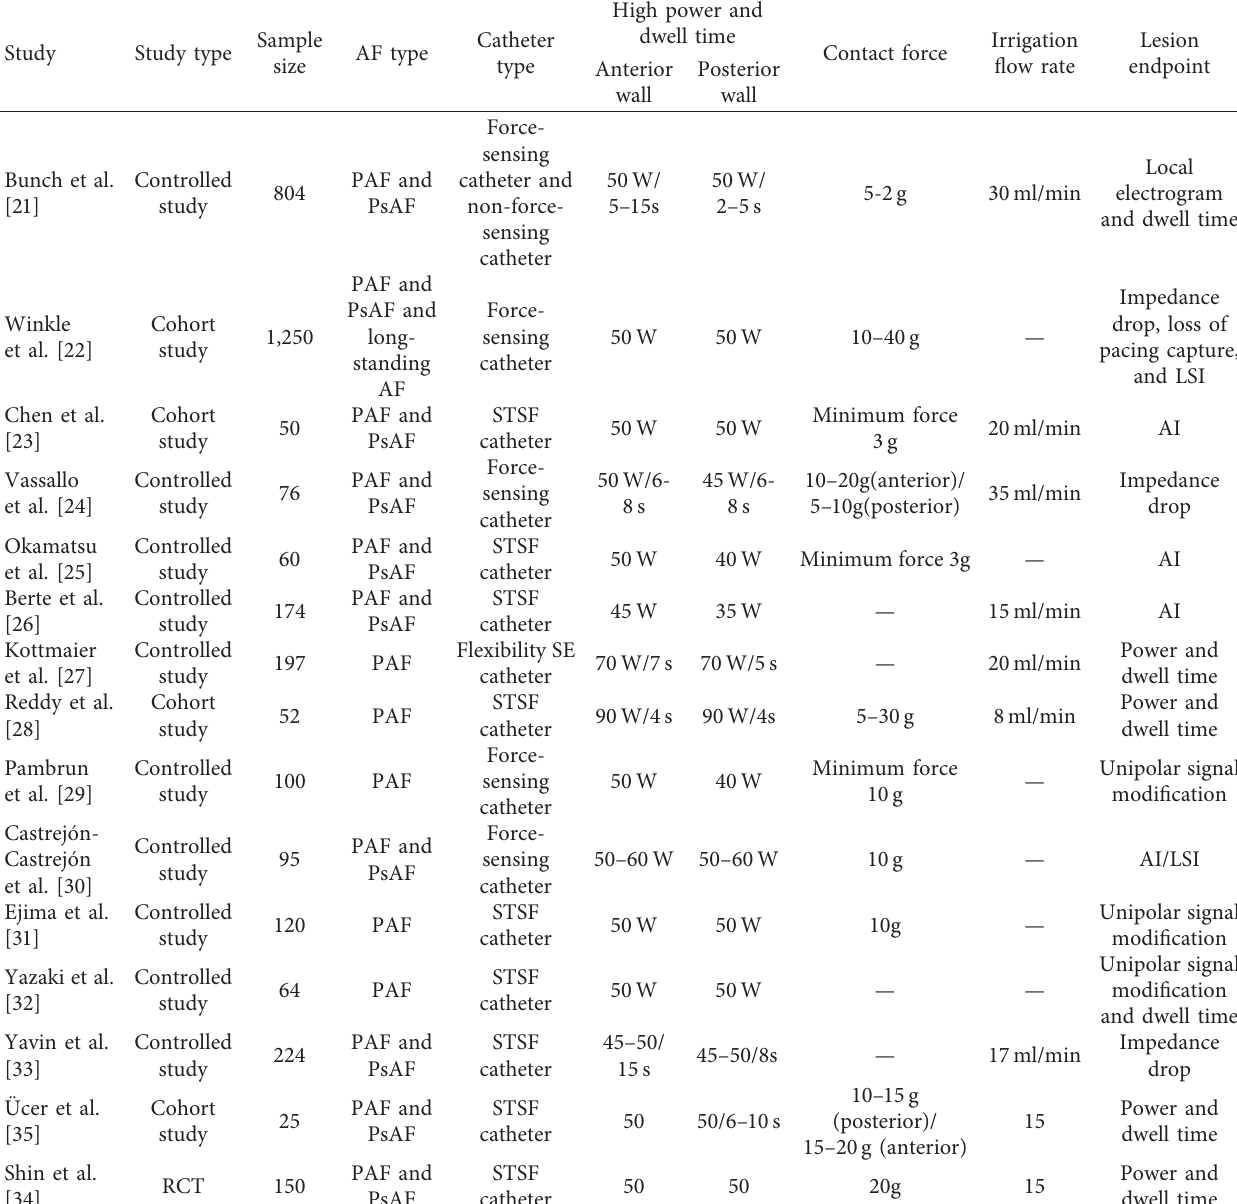
Table 2: The HPSD RF ablation settings and lesion endpoint in published clinical studies.